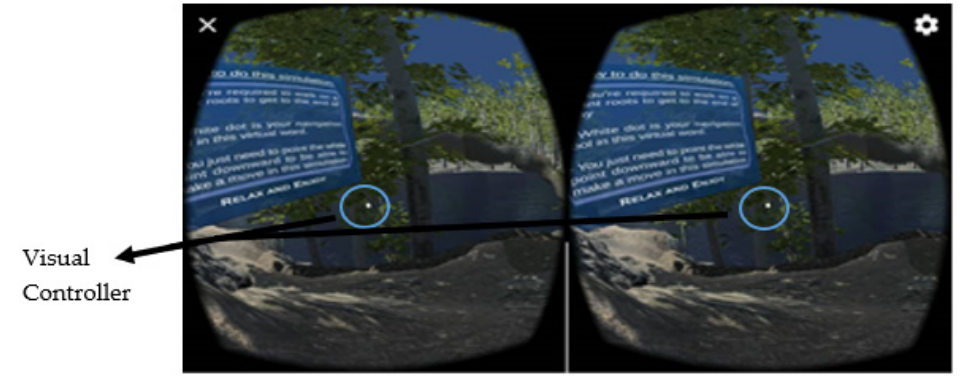
Figure 4. Visual control on AIVE application. A display notice to guide the participant. During developing this visual interaction procedure, a minimum of 3 sensors are re- quired on a smartphone to be able to function as a head controller, namely: